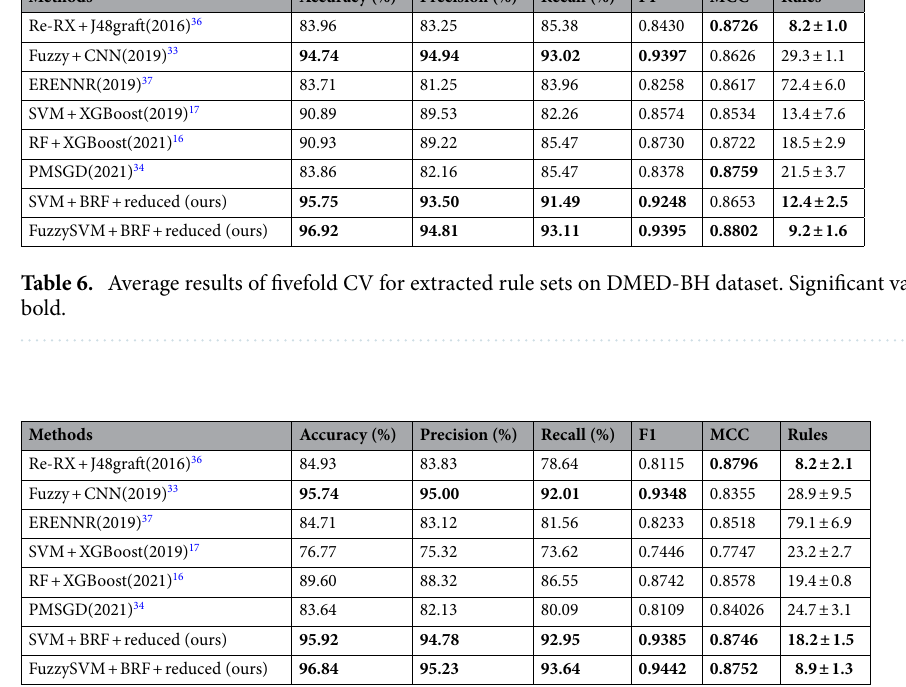
Table 7. Average results of fivefold CV for extracted rule sets on PID dataset. Significant values are in bold.